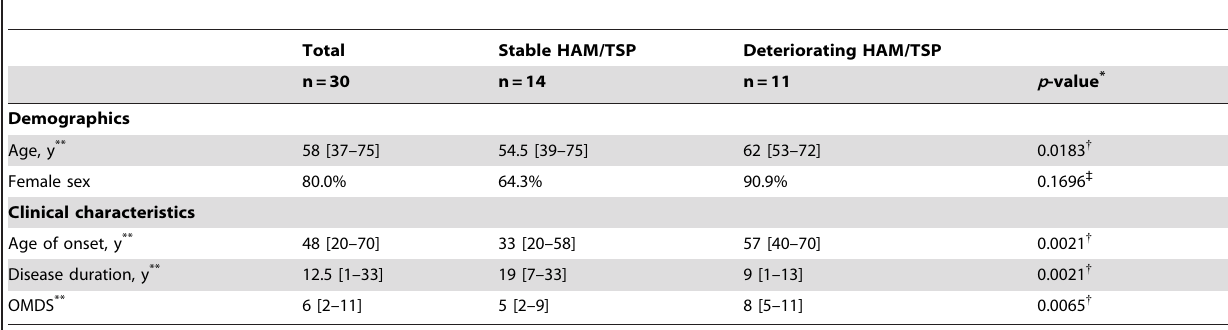
Table 2. Demographics and clinical characteristics of HAM/TSP patients (Training